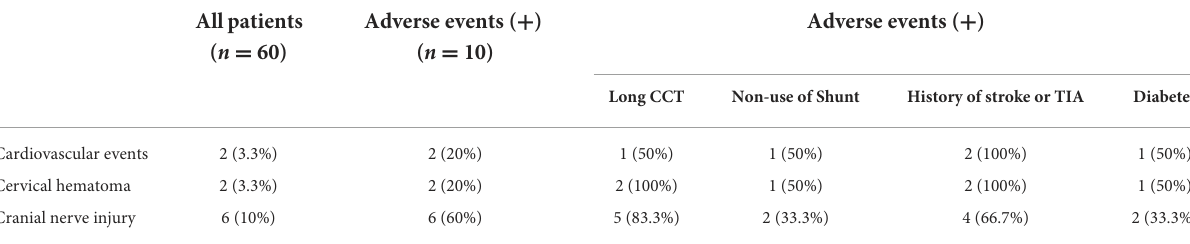
TABLE 2 Description of postoperative adverse